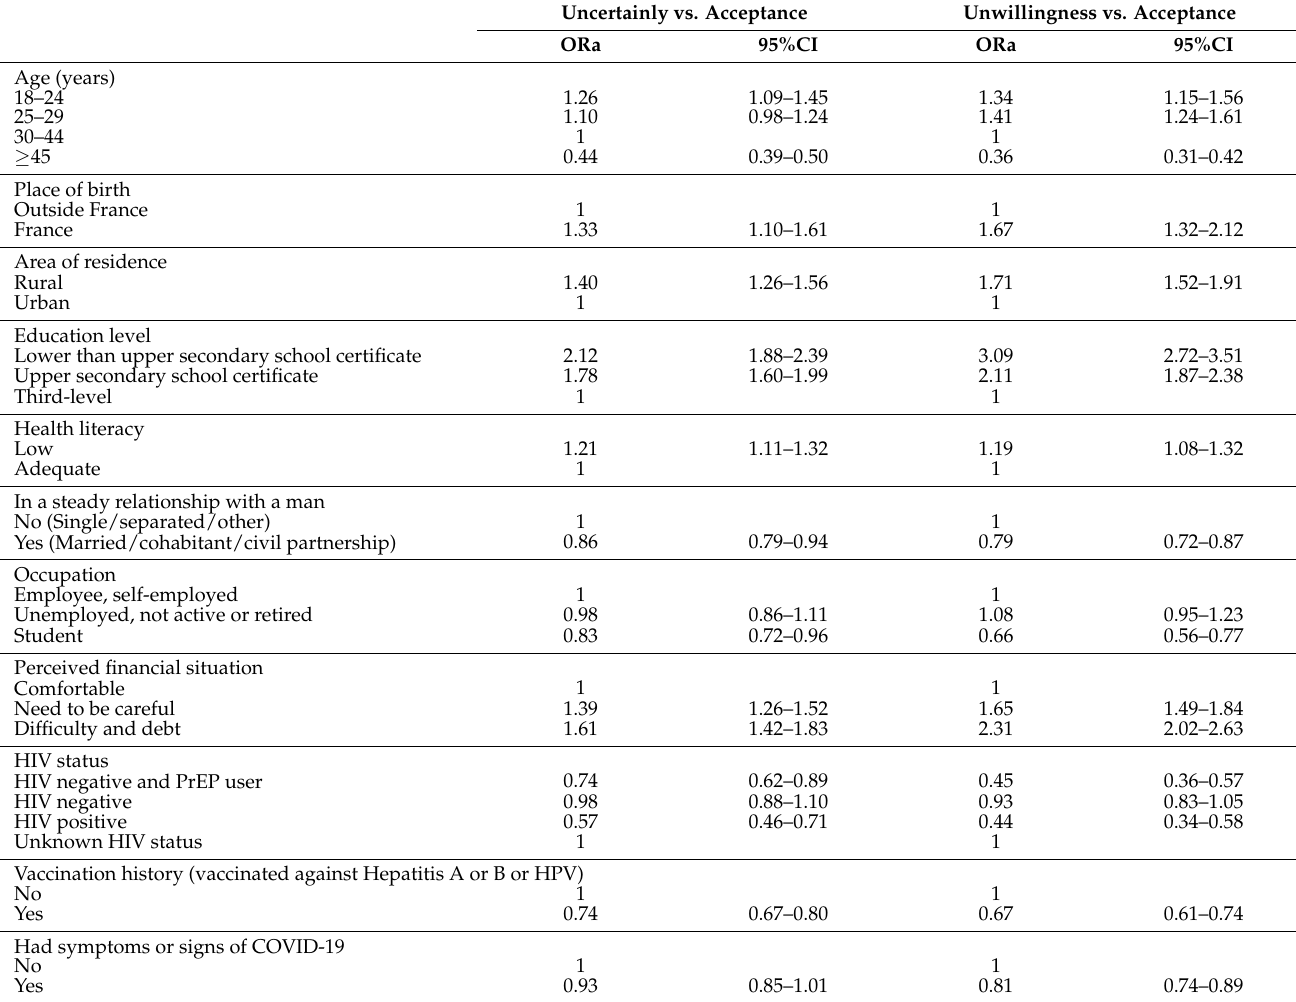
Table 3. Multivariate analyses using multinomial logistic models of factors associated with intention to vaccinate against COVID-19 ( n = 15,426). Uncertainly vs.